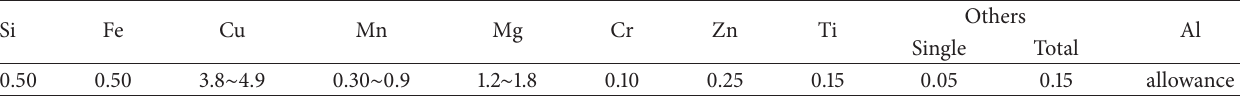
Table 1: The composition and content of aluminum alloy 2024